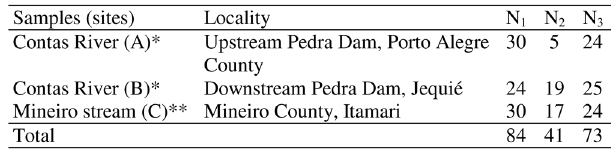
), cytogenetic (N ), and molecular 1 2